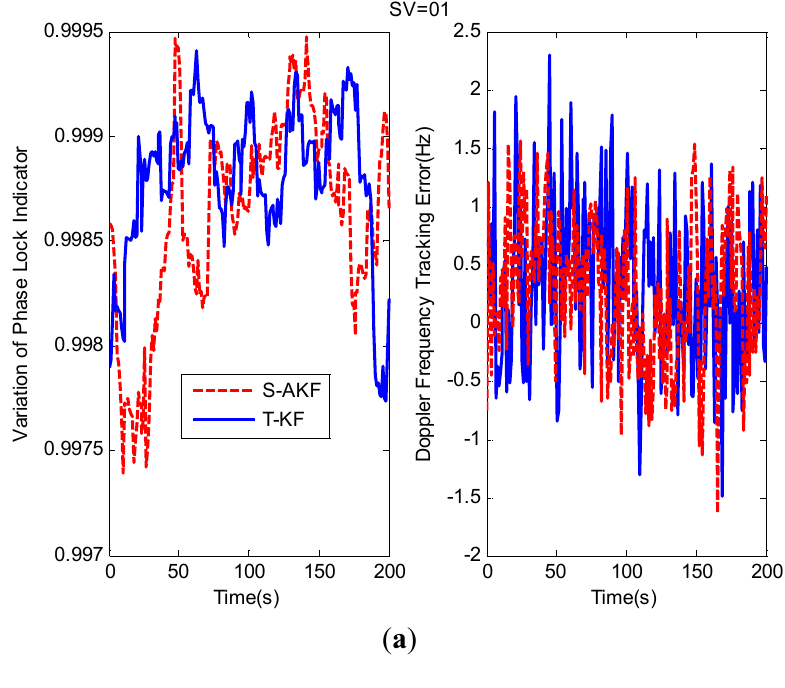
Figure 11. ( a ) Tracking performance comparison for SV01; ( b ) Tracking performance comparison for